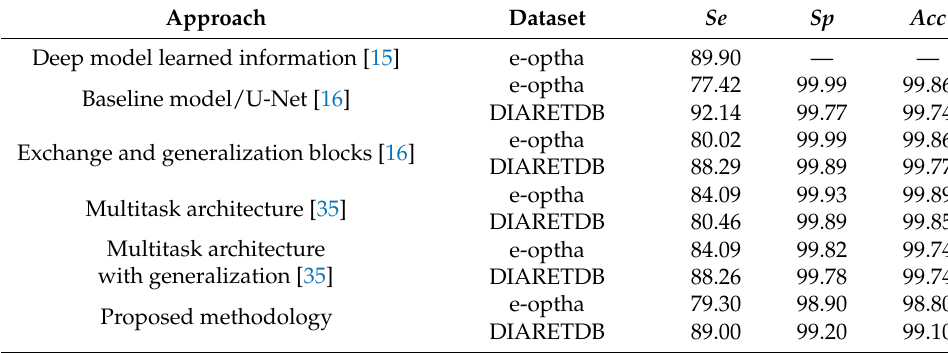
Table 4. Comparative results with state-of-the-art